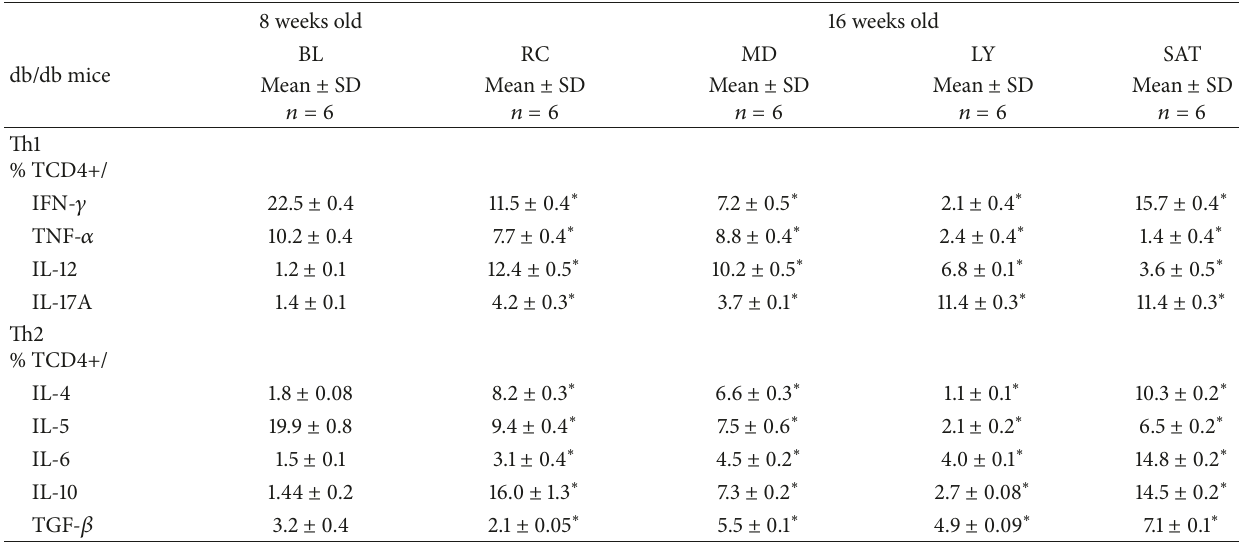
Table 4: Effect of supplementation with EPA and DHA fatty acids extracted from microalgae on Th1 and Th2 cytokines in db/db. 8 weeks db/db mice